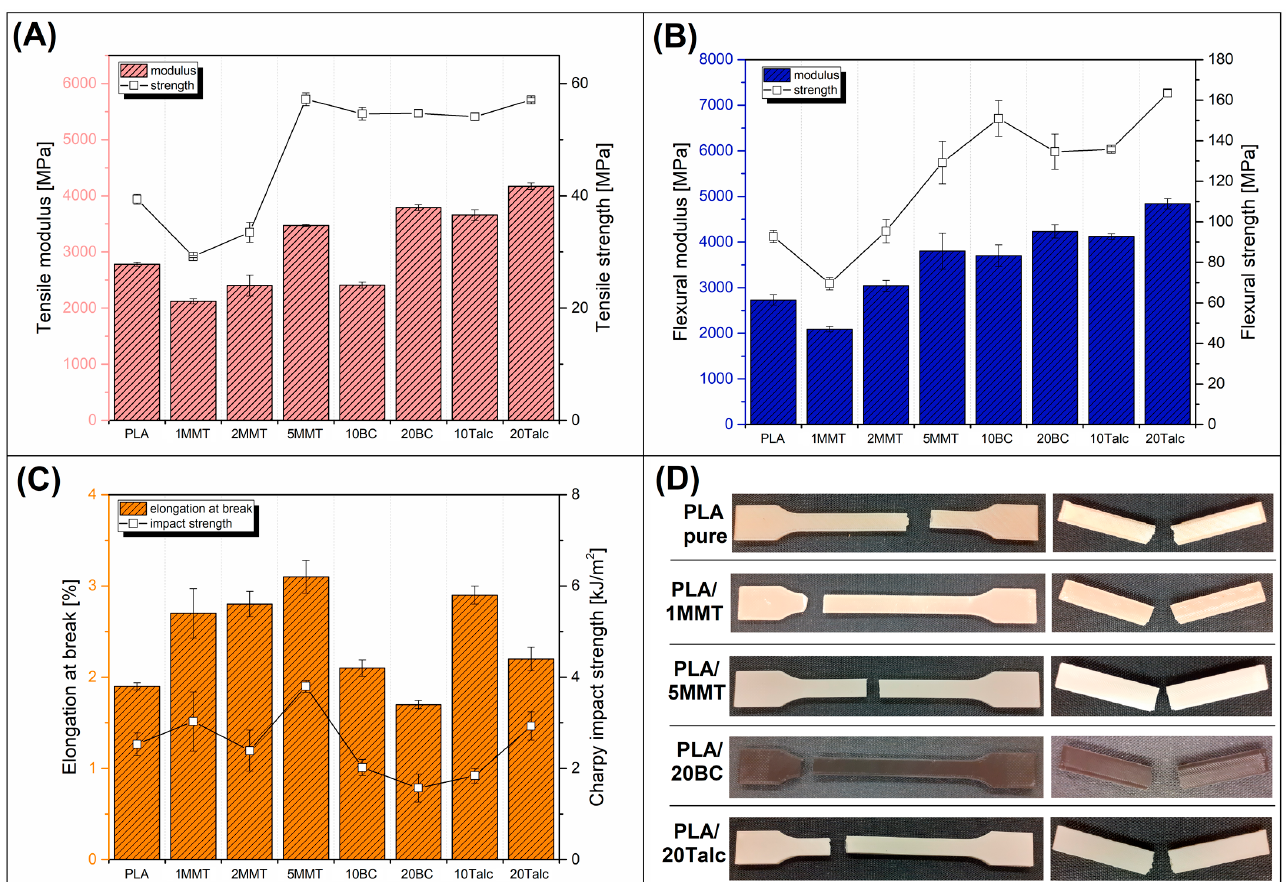
Figure 3. The results of the mechanical properties evaluation. ( A ) tensile modulus and strength; ( B ) flexural modulus and strength; ( C ) elongation at break and impact strength; ( D ) the appearance of samples after testing.